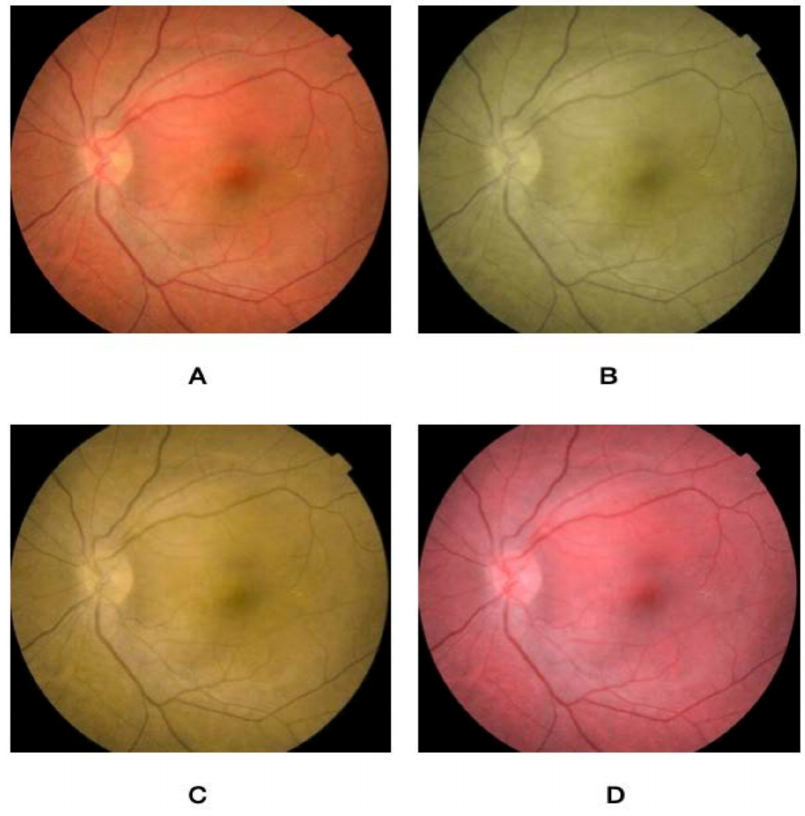
Figure 2. Fundus images for circumscribed choroidal hemangioma ( A ), under simulated protanopia ( B ), deuteranopia ( C ), and tritanopia ( D